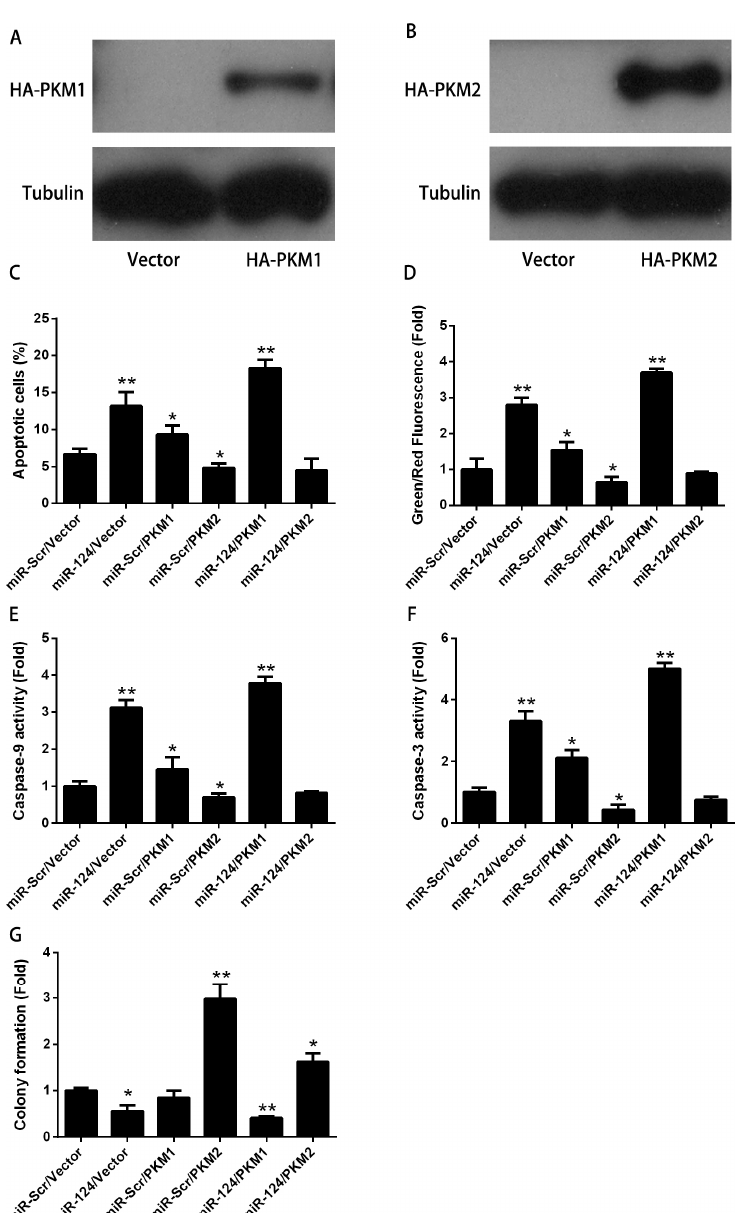
Figure 2. miR-124-induced apoptosis is dependent on the PKM gene. To investigate the involvement of PKM1 or PKM2 in the apoptosis induced by miR-124, HA tagged PKM1 ( A ) and HA tagged PKM2 ( B ) were used. HCT116 cells were cotransfected with miR-124 together with HA tagged PKM1 or HA tagged PKM2, miR-Scr represented the scrambled miRNA, and vector represented the empty plasmid for 48 h; ( C ) Apoptosis; ( D ) Mitochondrial membrane potential; ( E ) Caspase-9 activity; ( F ) Capase-3 activity; ( G ) Colony formation assay. The data are presented as mean ± SD of three independent experiments. * p < 0.05 vs. control, ** p < 0.01 vs.